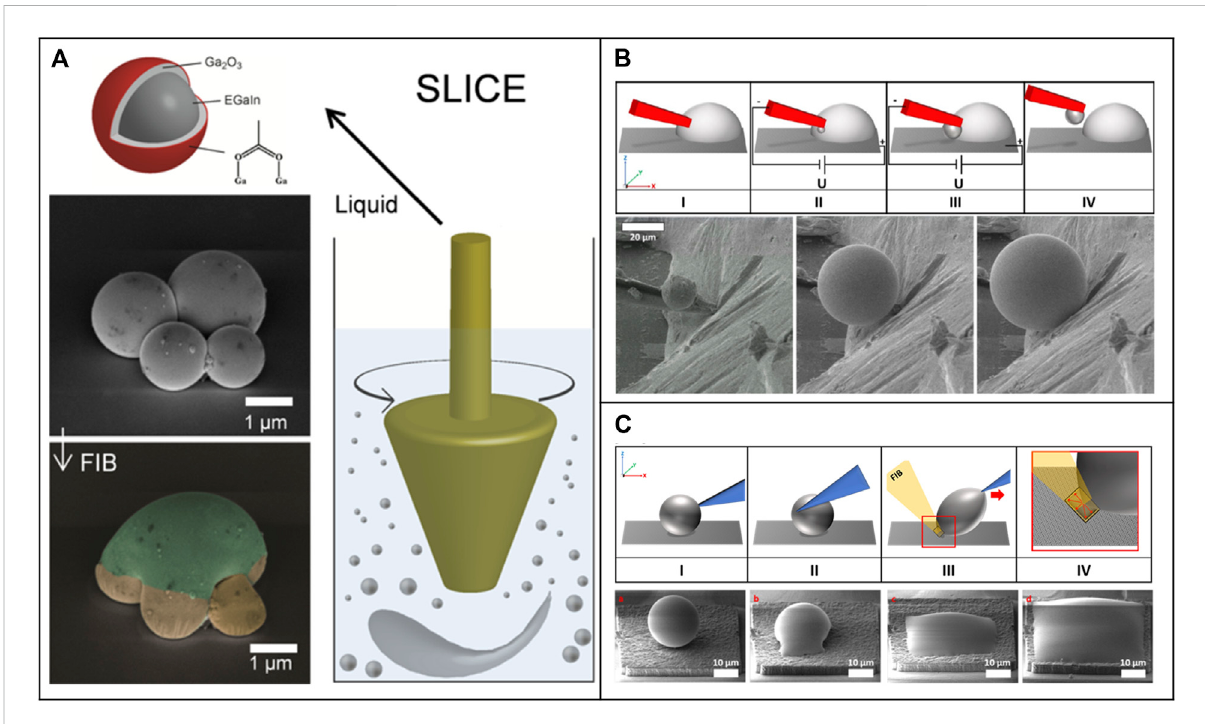
FIGURE 8 Three main techniques for manipulation of liquid metals on the small scale; (A) The Shearing Liquids Into Complex Particles (SLICE) Technique uses a blender for surface tension driven phase segregation. The resulting liquid metal volumes can then be merged with an FIB. Adapted with permission from (Tevis et al., 2014). Copyright 2022 American Chemical Society; (B) Electromigration induced mass fl ow can be applied for the controlledfabricationofliquidmetaldroplets.Themass fl owstrengthanddirectioncanbecontrolledbyanexternalelectric fi eld.Adaptedwith permission from (Kleist-Retzow von et al., 2019b); (C) Forced wetting by ion implantation leads to the ability to structure the liquid metal to arbitrary twodimensional geometriesonade fi ned surface. Fortheion implantation an FIBsystemcan beused. Adaptedwith permissionfrom(Kleist-Retzow and von,